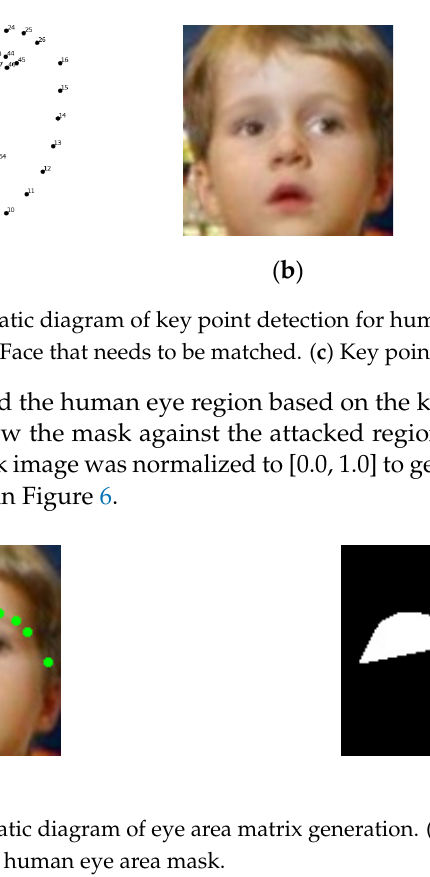
point from the target key point. We split the sample and updated the current key point